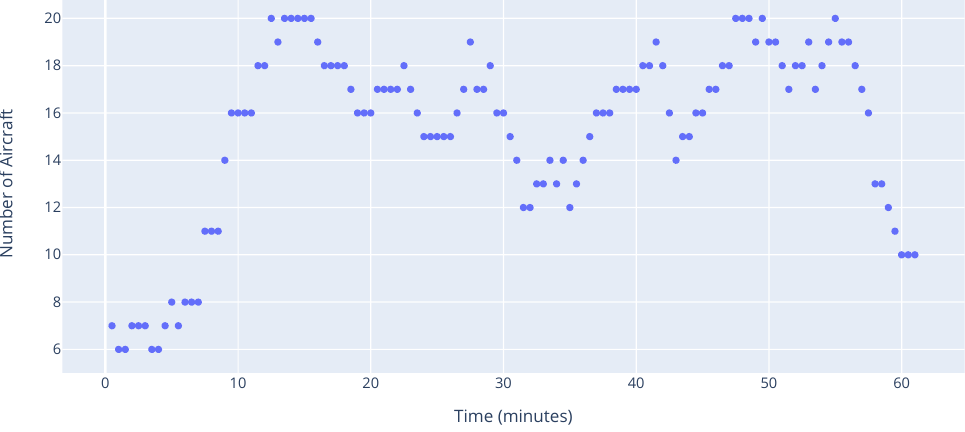
Figure 15. Number of flights present in the sector.